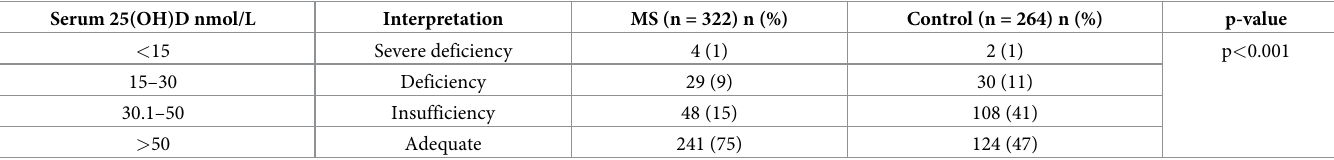
Table 3. Vitamin D status of MS and matched controls based on 25(OH)D levels. Serum 25(OH)D